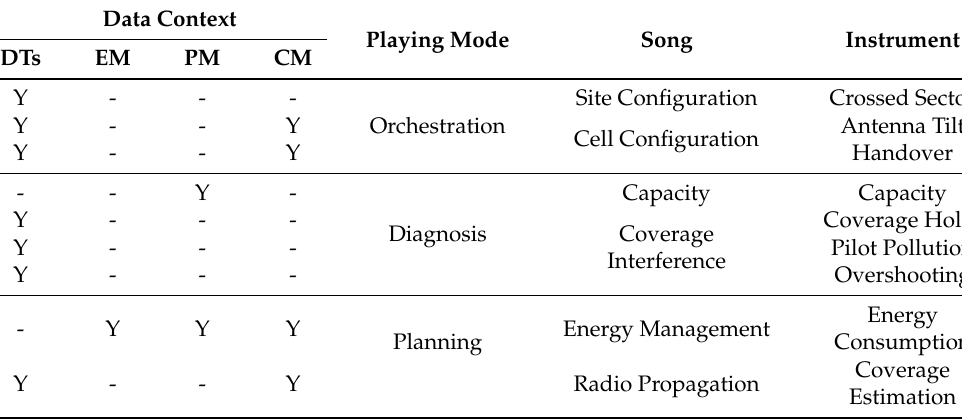
Table 1. RAN algorithm (instrument) selection